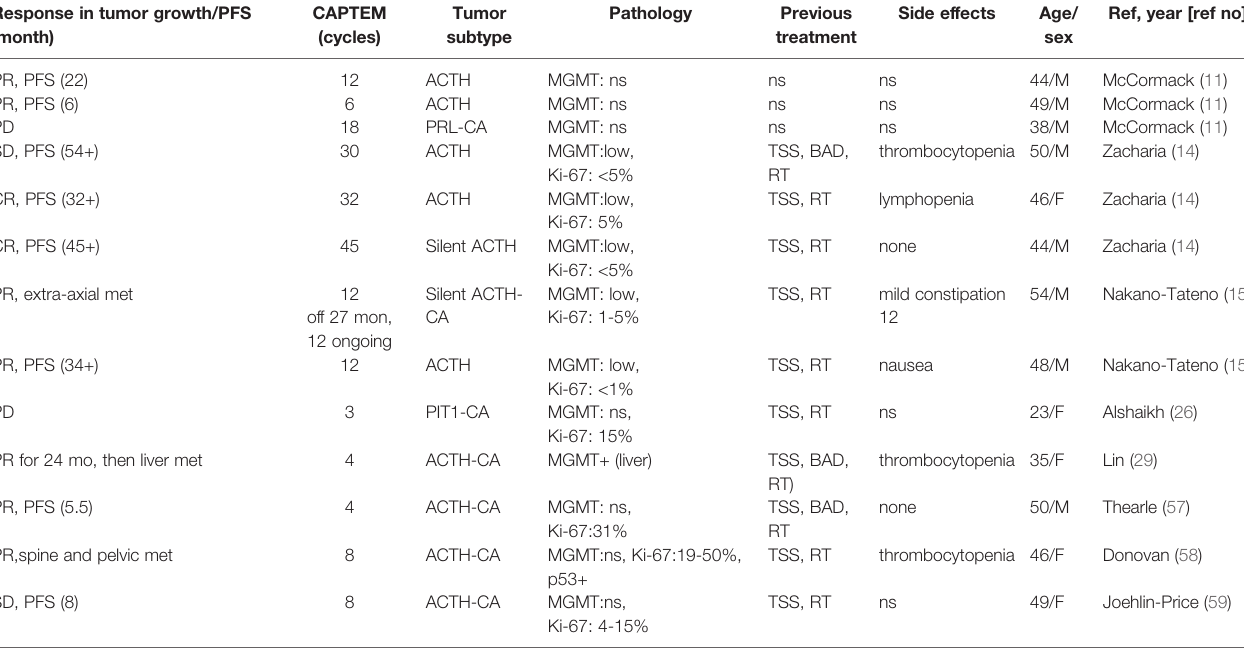
TABLE 2 | Published cases of Capecitabine (pro-drug of 5-Fluorouracil) + Temozolomide (CAPTEM) (TMZ naïve) for aggressive pituitary tumors and carcinomas. Response in tumor growth/PFS